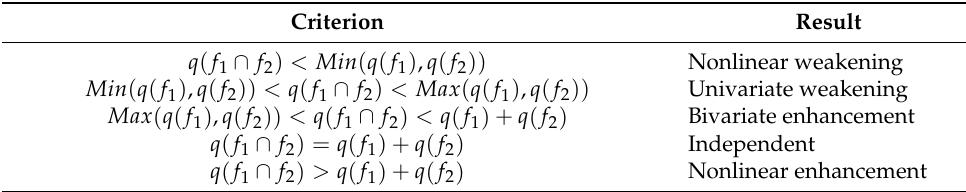
Table 3. The type of interaction when two factors.